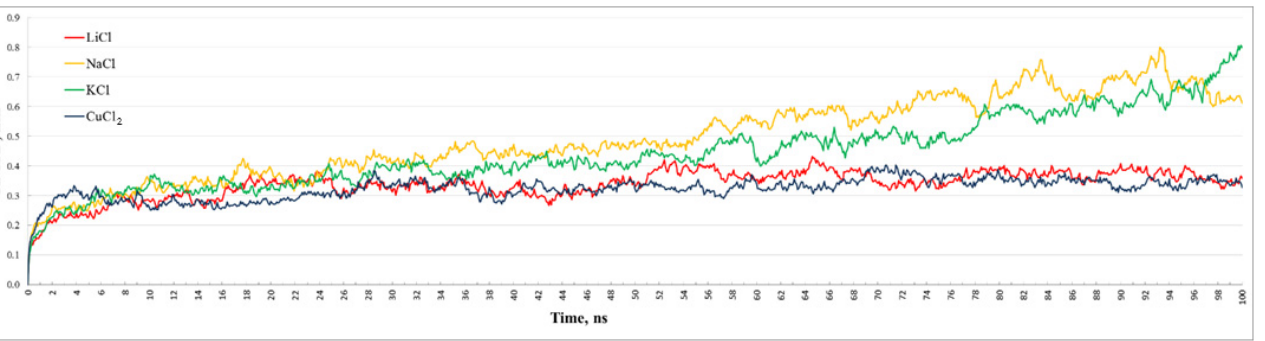
Figure 5. RMSD of octamers with different precipitants: LiCl, NaCl, KCl and CuCl 2 . The radius of gyration characterizes the size (compactness) of a protein. It is calculated as the root-mean-square distance of all the atoms in the protein from the centre of mass of the molecule.